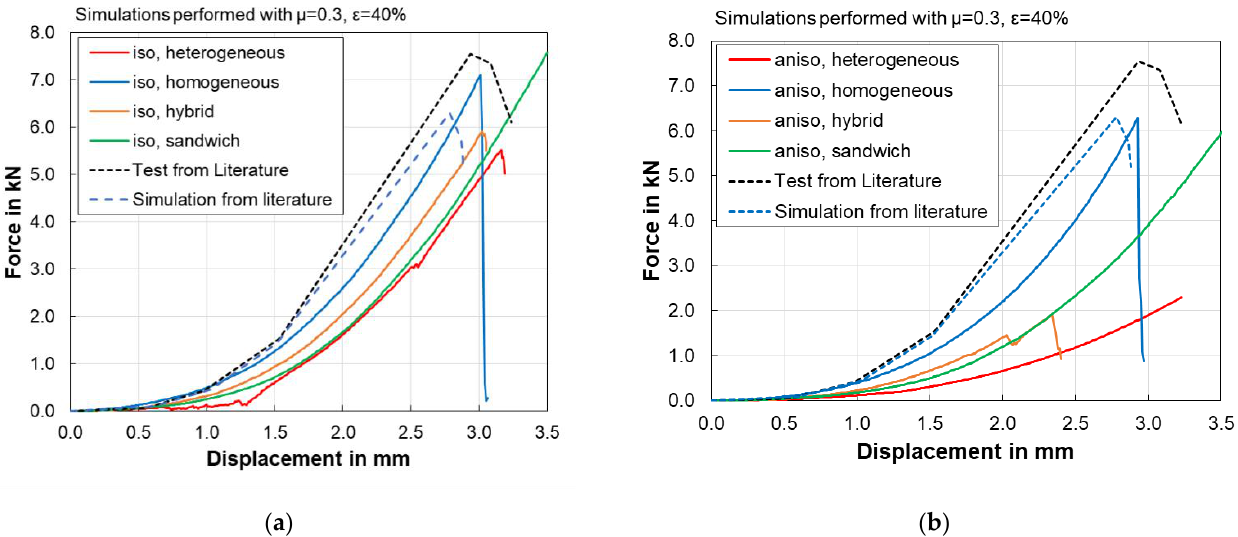
Figure 20. Comparison of the force-displacement outputs among all models: ( a ) models with isotropic material properties; ( b ) models with anisotropic material properties.